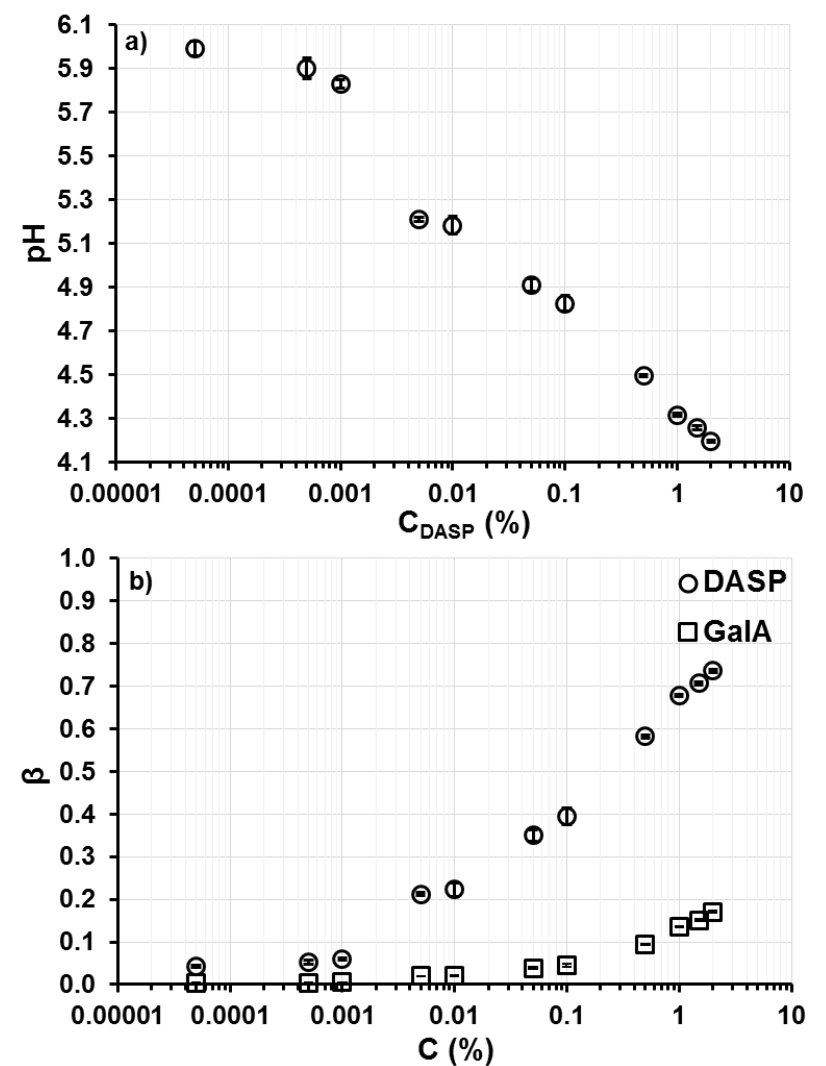
Figure 5. ( a ) Relationship between the pH of the samples and the DASP fraction concentration (C DASP ) and ( b ) the dependence of the degree of hydrogen ion binding ( β ) on concentration (C) of the DASP fraction (circles) and galacturonic acid (squares); bars indicate standard deviation.